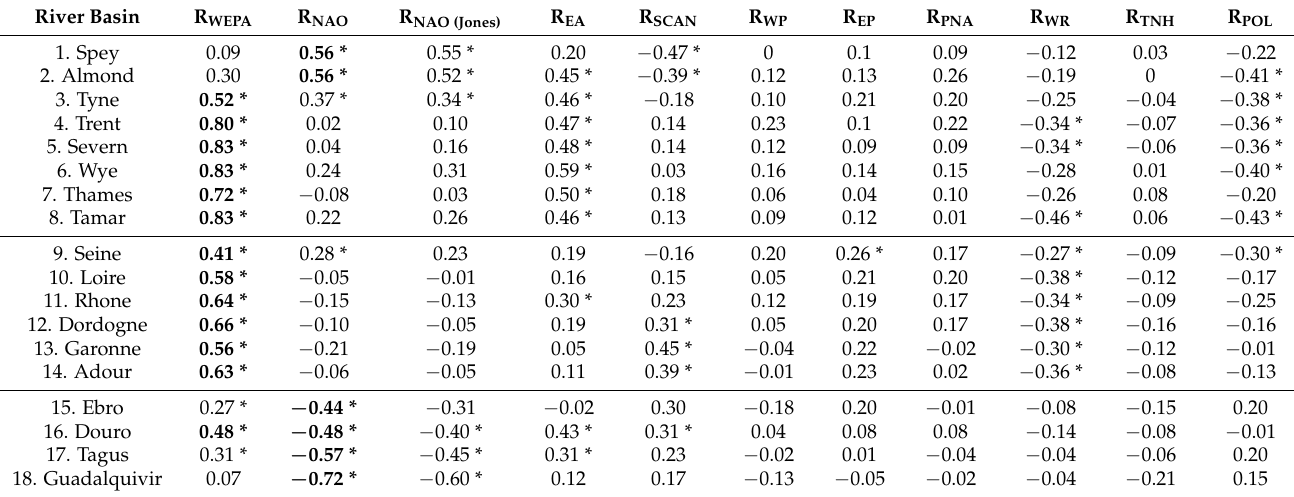
Table 2. Correlation R between winter-mean (DFJM) river discharge and winter-averaged teleconnection indices, including the WEPA climate index. The strongest correlation for each river basin is highlighted in bold. * indicates statistically significant correlations at p <